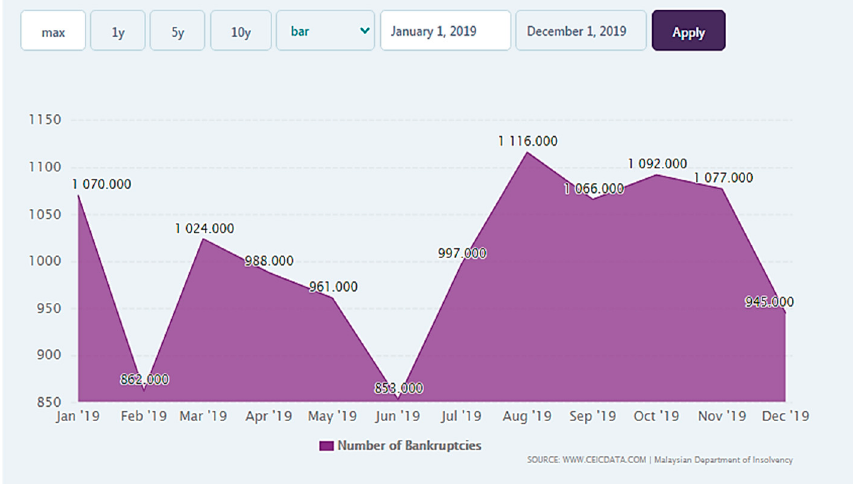
Figure 2. Diagram of bankruptcies in Malaysia in 2019.